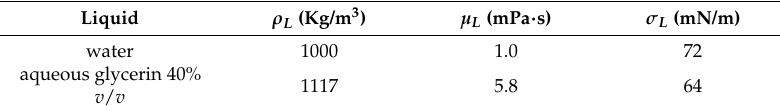
Table 3. Liquid phase properties.